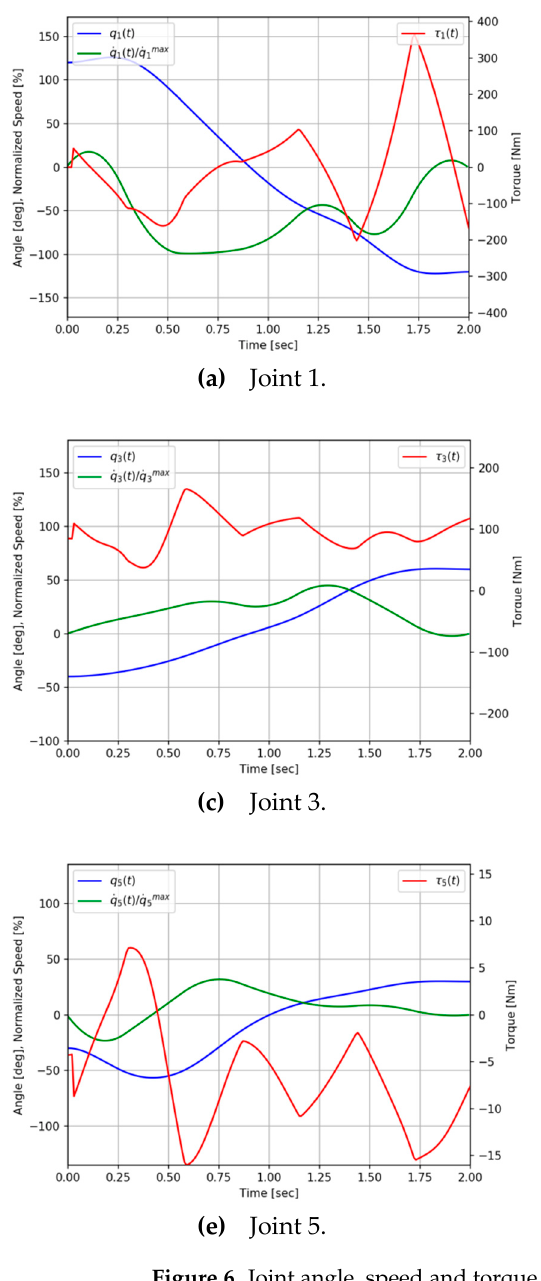
Figure 6. Joint angle, speed and torque profiles for the optimal motion (Case 1).